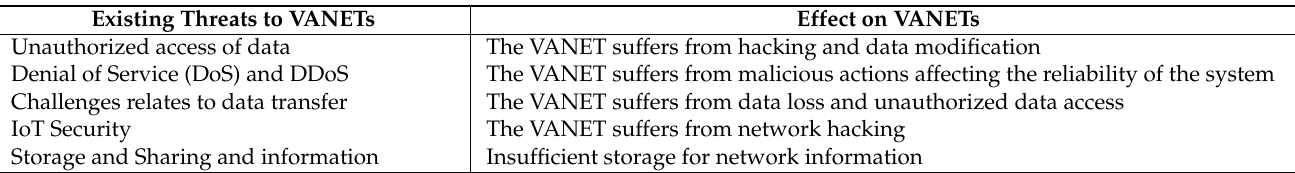
Table 1. Existing threats to VANTEs and their effects